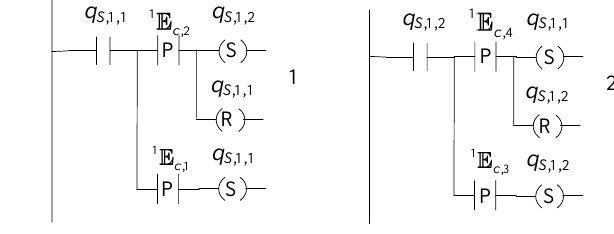
Figure 12. State diagram of